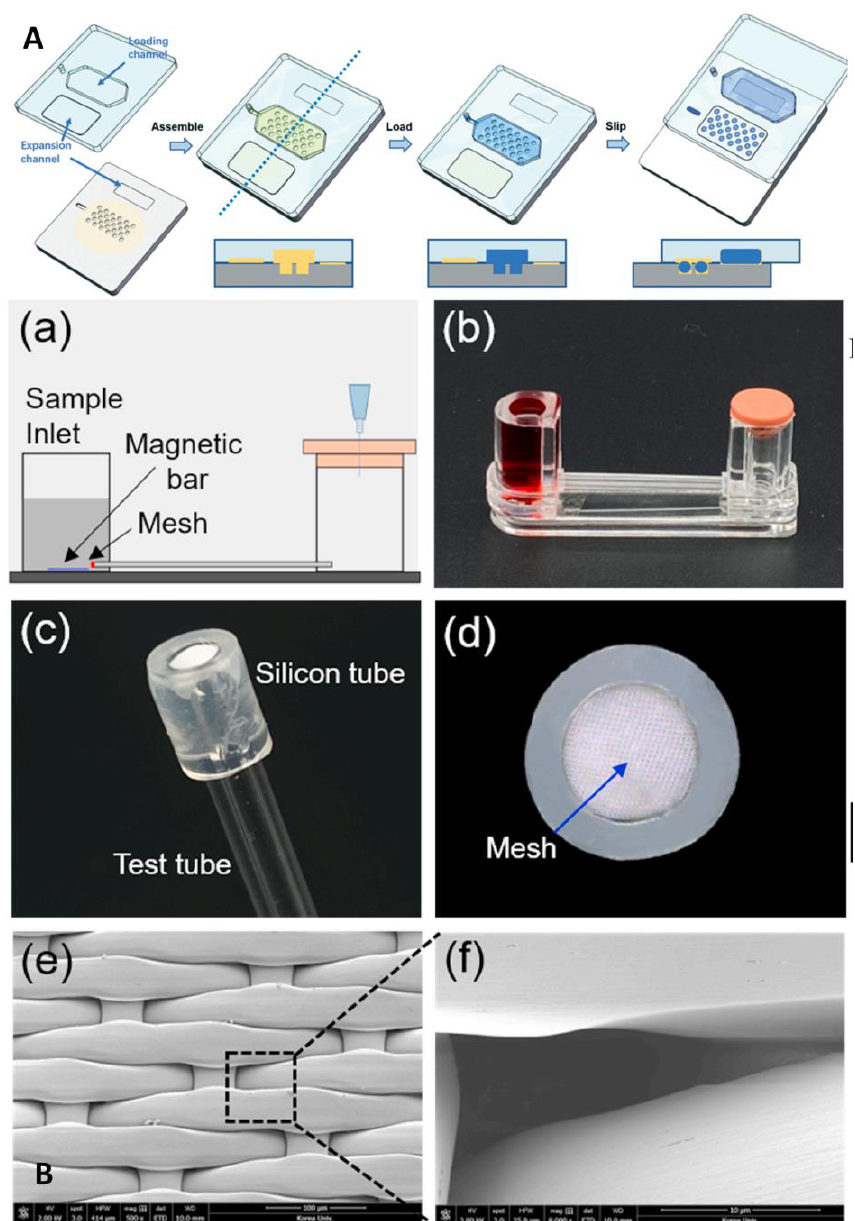
Figure 8. Microfluidic laboratory based on isothermal amplification technology. ( A ) Schematic demonstrating the da-Slip Chip for the slip formation of droplets at a high density. Reproduced with permission from Lyu, W., Lab on a chip , published by Royal Society of Chemistry, 2021 [57]. ( B ) Schematics depicting the use of DNA hydrogel formation on microfluidic pores to detect SARS-CoV-2: ( a ) experimental setup; ( b ) experimental apparatus; ( c ) flexible silicon tube bonded to the nylon mesh and glass tube; ( d ) front view of the silicon tube that prevent leaks; ( e ) scanning electron image of the nylon mesh; ( f ) scanning electron image of a single micro-hole of the nylon mesh. Reproduced with permission Kim, H. S., Biosensors and Bioelectronics , published by Elsevier, 2021 [58].